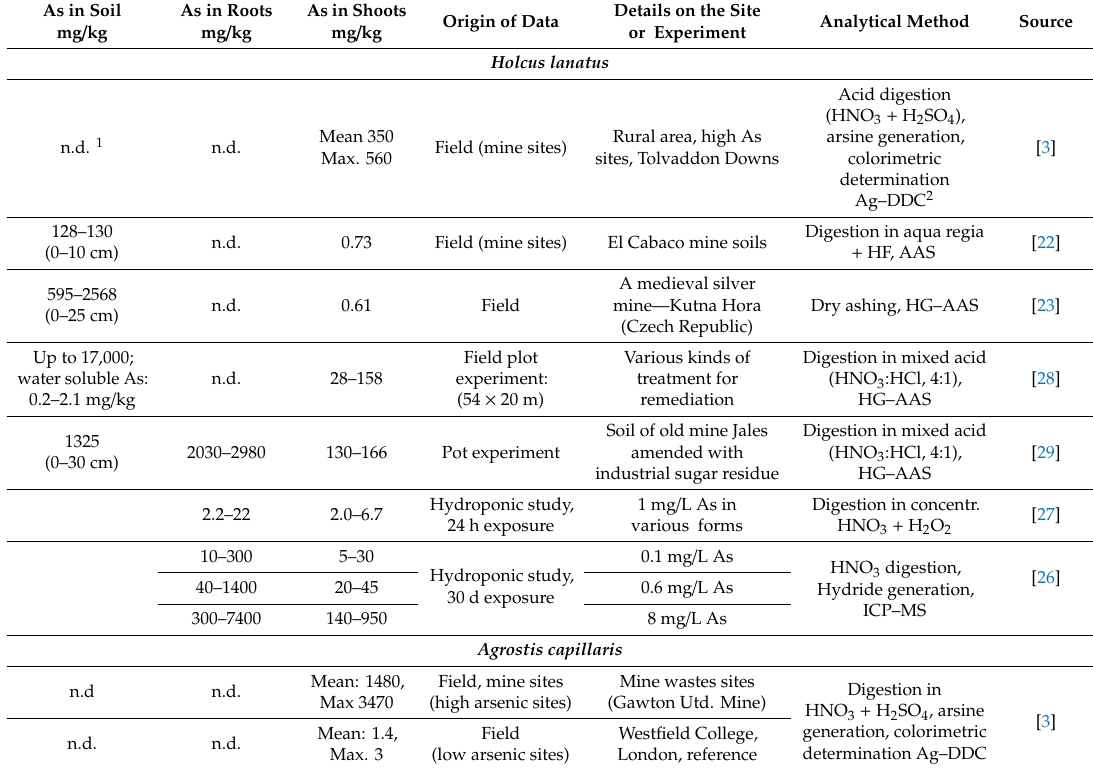
Table 1. Concentrations of As in the roots and shoots of Holcus lanatus and Agrostis capillaris reported from soils enriched in As or from As-supplied